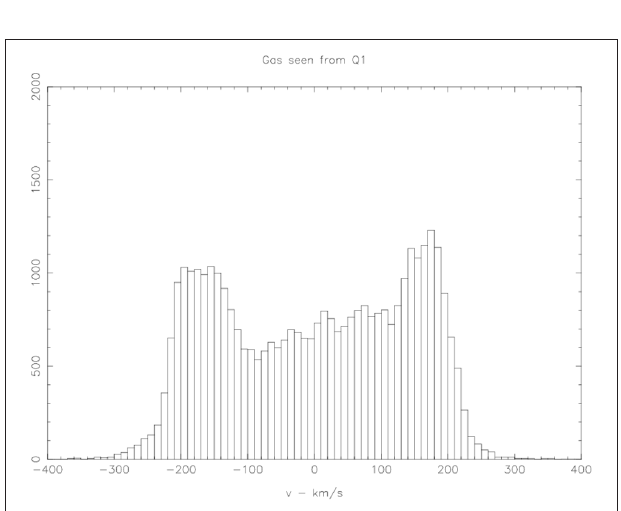
FIGURE 11 | Neutral hydrogen profile viewed from one of the disk